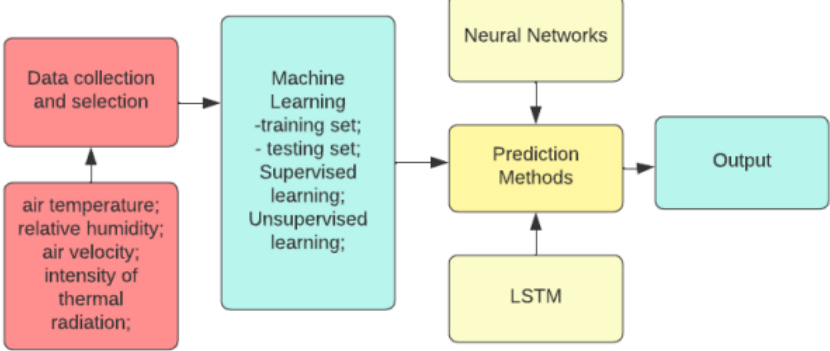
Figure 6. Prediction with Machine